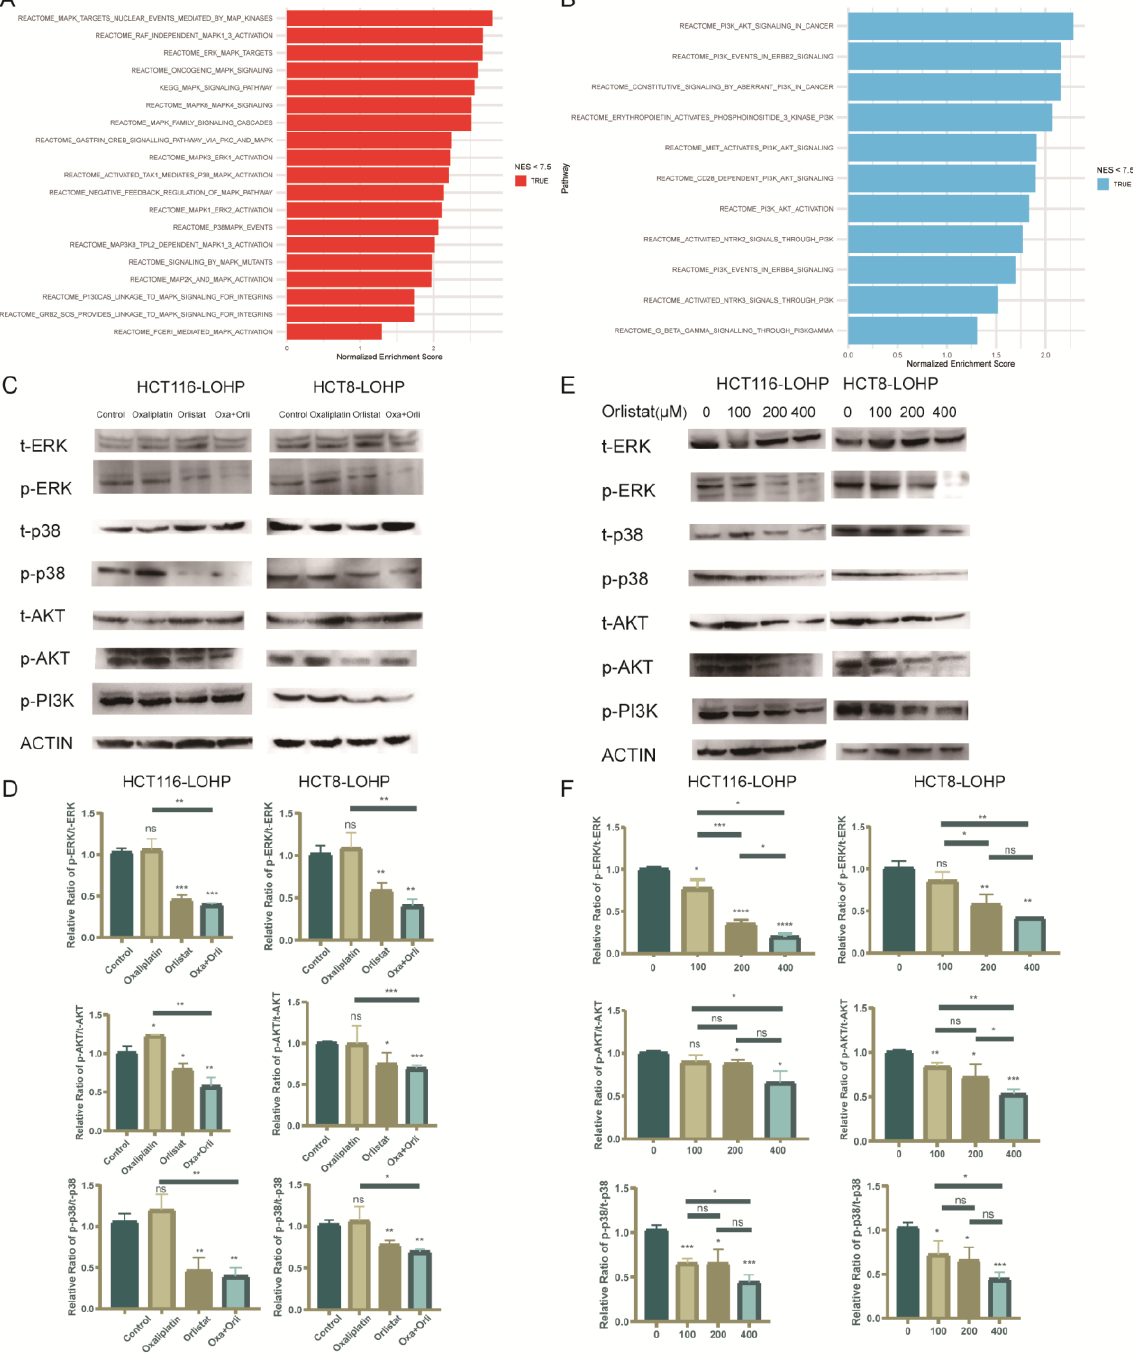
Figure 5. Phosphorylation of MAPK/ERK and PI3K/AKT pathways was involved in the process by which Orlistat enhances anti-proliferation effect of oxaliplatin. ( A , B ) Genome-wide RNA sequencing (RNA-seq) analysis was performed on HCT8-LOHP cells. Gene ontology (GO) analysis compared untreated cells with Orlistat treatment schemes and depicted the most significant change in signaling pathways. Compared with cell lines treated with Orlistat, MAPK/ERK ( A ) and PI3K/AKT ( B ) pathways were activated more. ( C , D ) There was a distinct change in phosphorylation of MAPK/ERK and PI3K/AKT pathways in cell lines exposed to oxaliplatin, Orlistat, and both. Western blot analysis depicted that whether oxaliplatin was utilized or not, Orlistat could inhibit phosphorylation of MAPK/ERK and PI3K/AKT pathways. Relative intensity ratio of each band on western blot see Table S2. ( E , F ) Under 20 µM oxaliplatin treatment, phosphorylation levels in 116-LOHP and HCT8-LOHP cell lines decreased with increasing concentration gradients of Orlistat. Relative